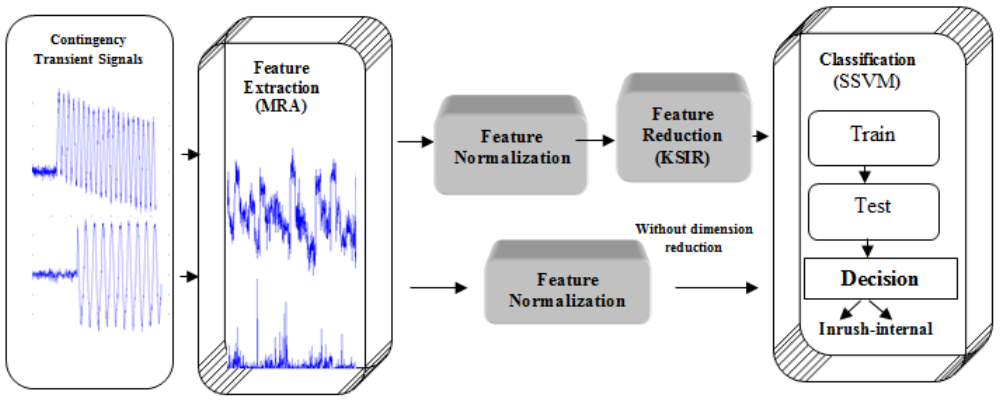
Figure 1. Framework of the proposed